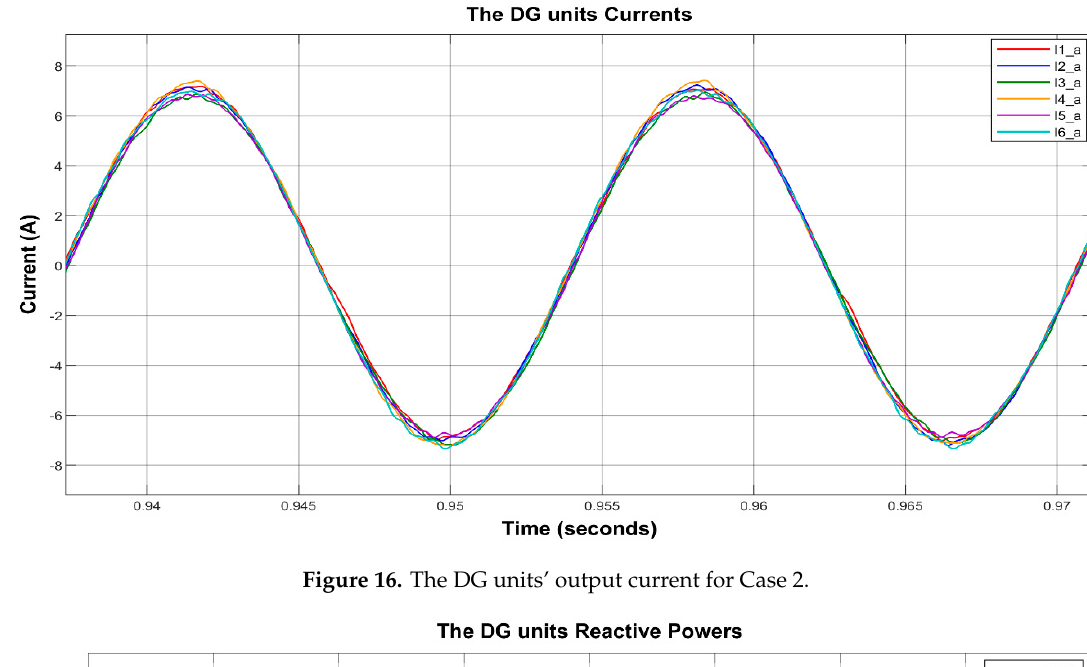
Figure 15. The DG units’ magnitude of phase a of output voltages for Case 2.